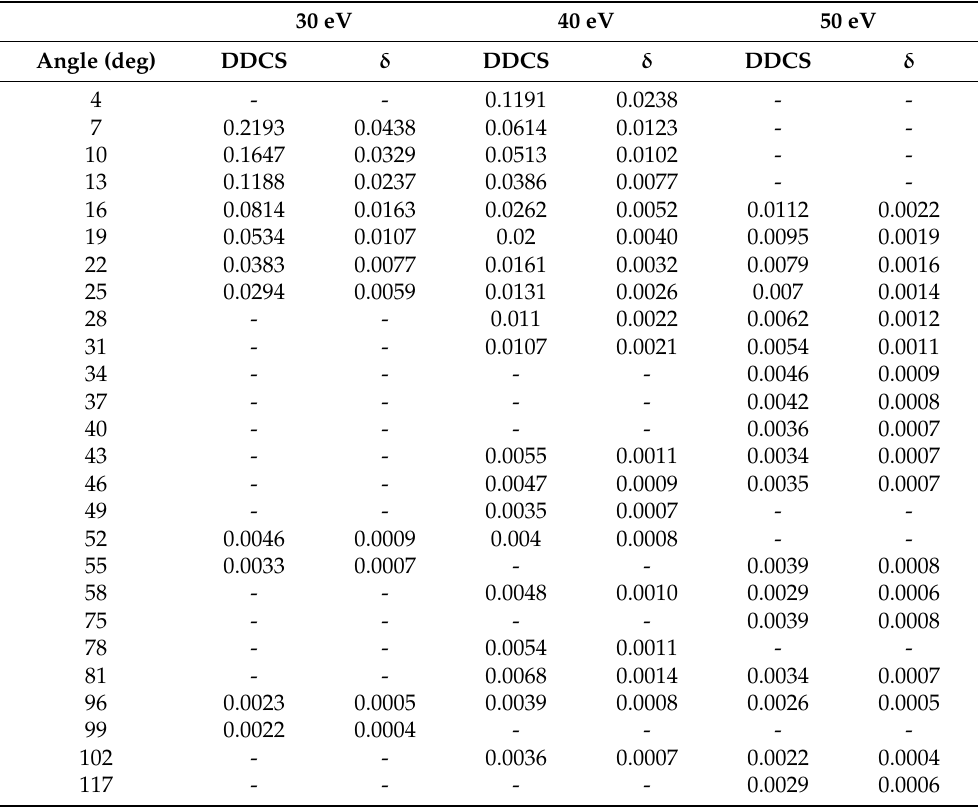
Table 2. Absolute DDCS for the production of the benzene parent ion C 6 H 6+ at the impact energy of 90 eV for different transferred electron energies together with their estimated uncertainties (units are 10 − 20 m 2 sr − 1